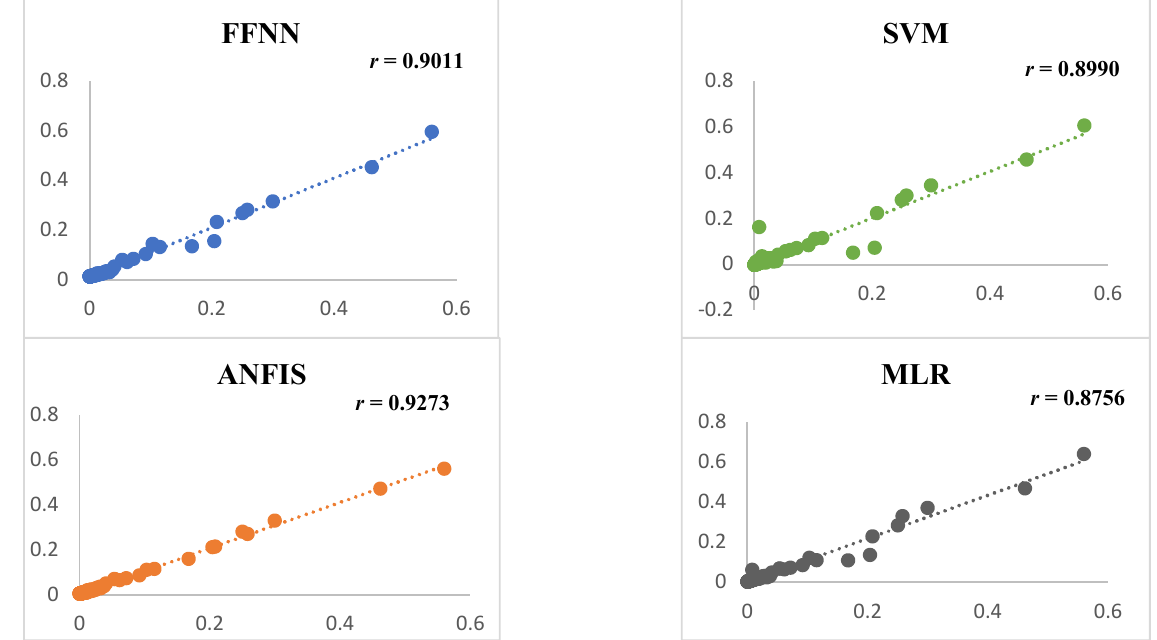
Figure 7. The actual and the predicted COVID-19 mortality rates using four single models at the verification phase.